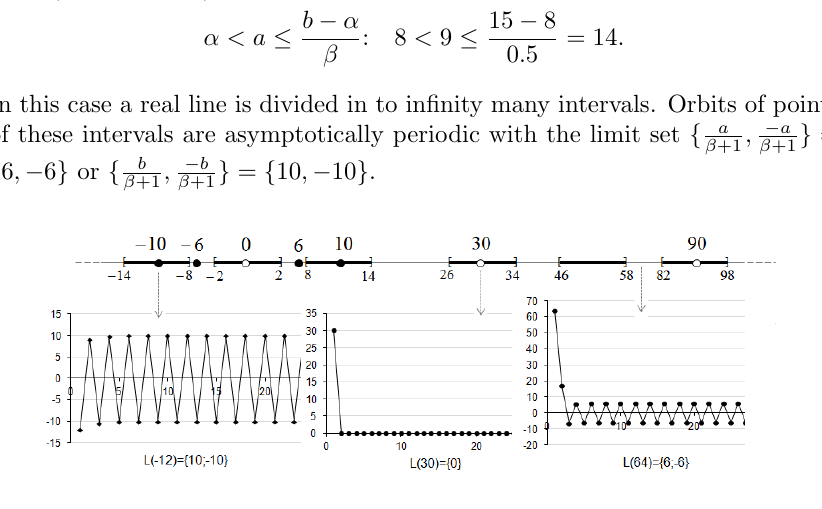
Figure 4. Illustration if x 0 ∈ {− 12;30;64 }